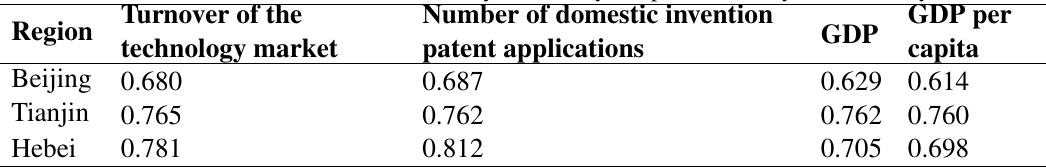
Table 7 Government Guidance Fund Policy and Policy Output Secondary Indicators by